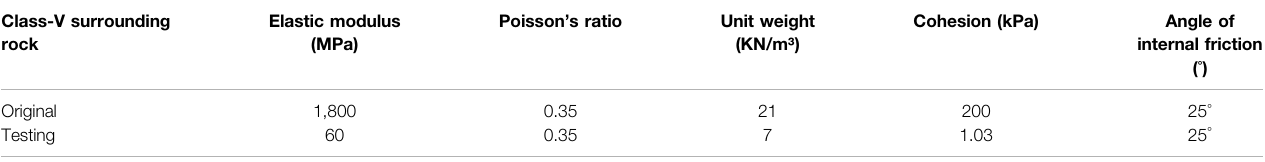
TABLE 4 | Major mechanical parameters of original surrounding rock and mixture materials.